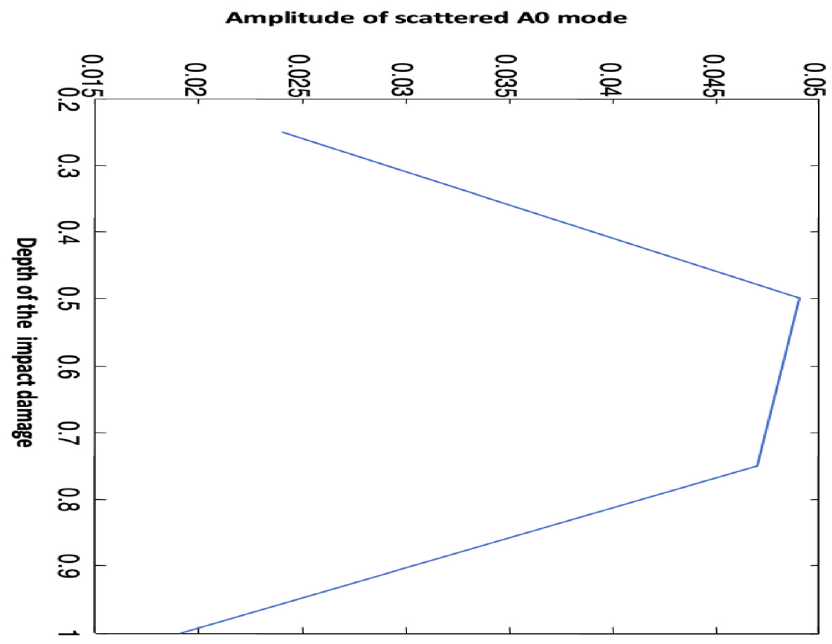
Figure 14. Effect of the through thickness of the conical defect on the scattered A 0 mode towards the 45° direction.